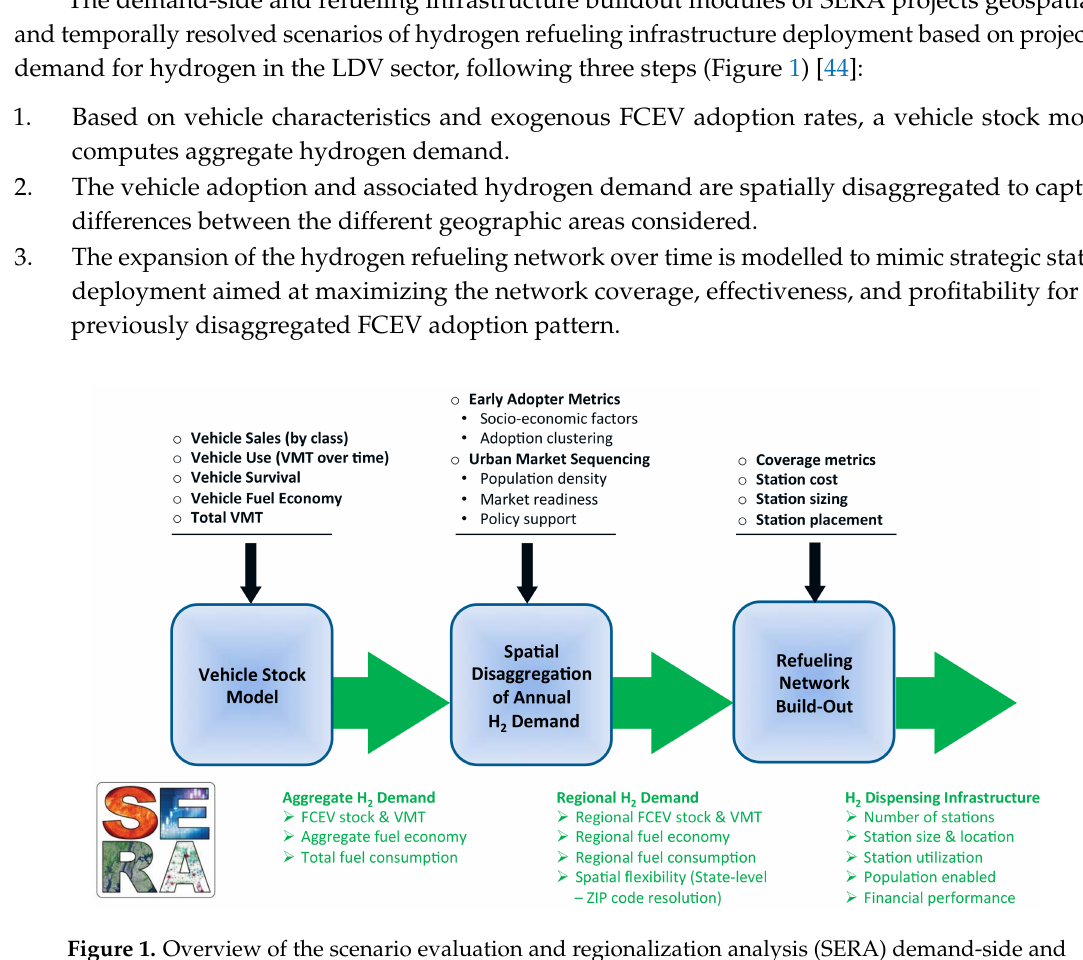
Figure 1. Overview of the scenario evaluation and regionalization analysis (SERA) demand-side and refueling infrastructure buildout modelling